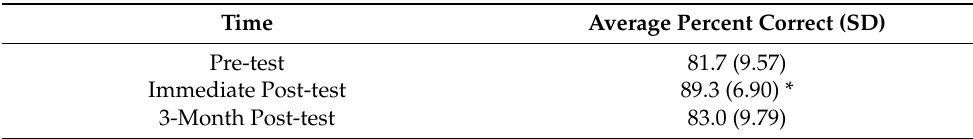
Table 3. Average percent correct on knowledge questions.